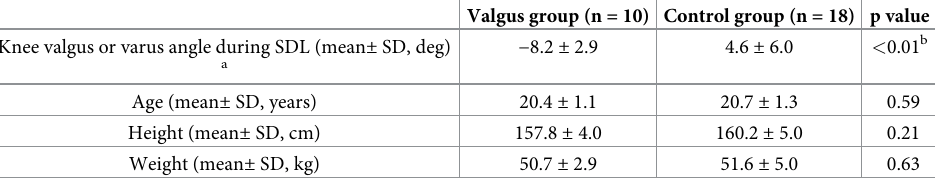
a Positive value indicates the knee varus angle, and negative value indicates the knee valgus angle. b Statistically significant at p <